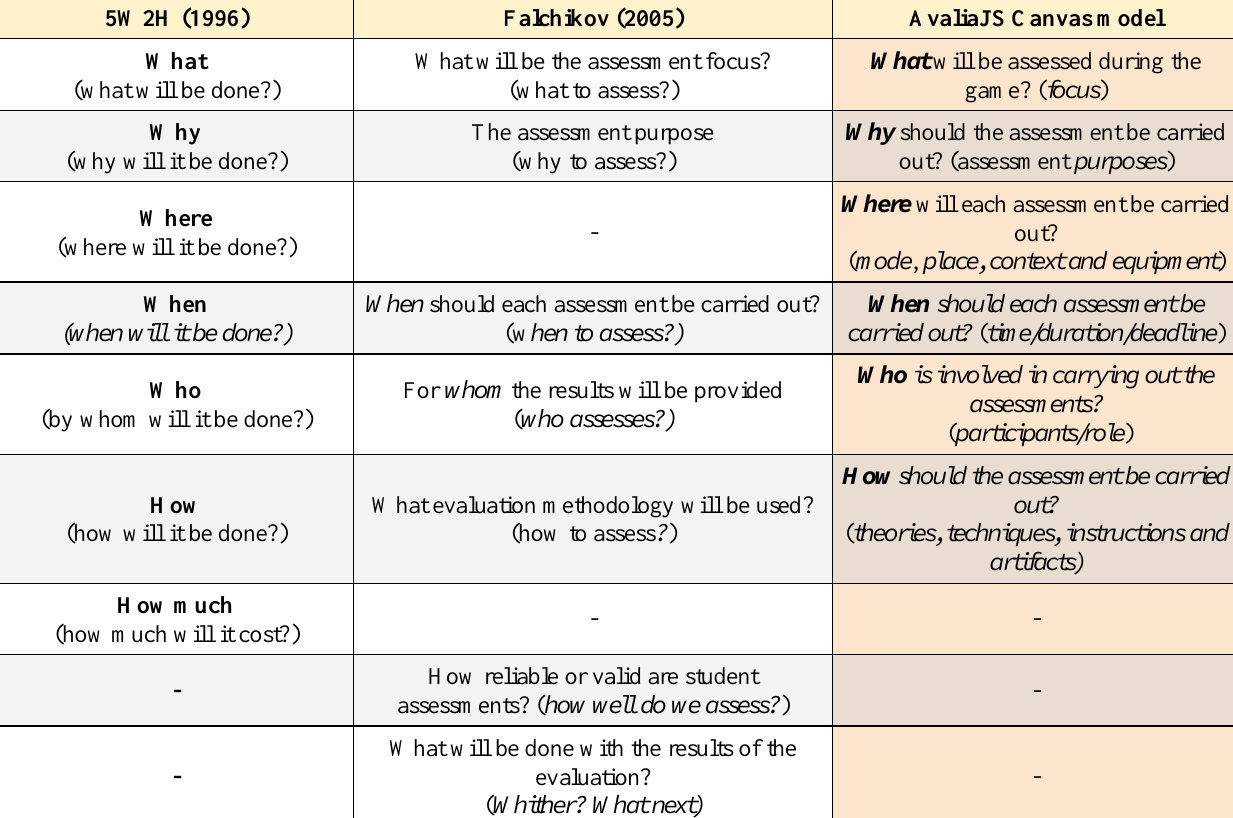
Table 1. Relationship among the questions for assessment